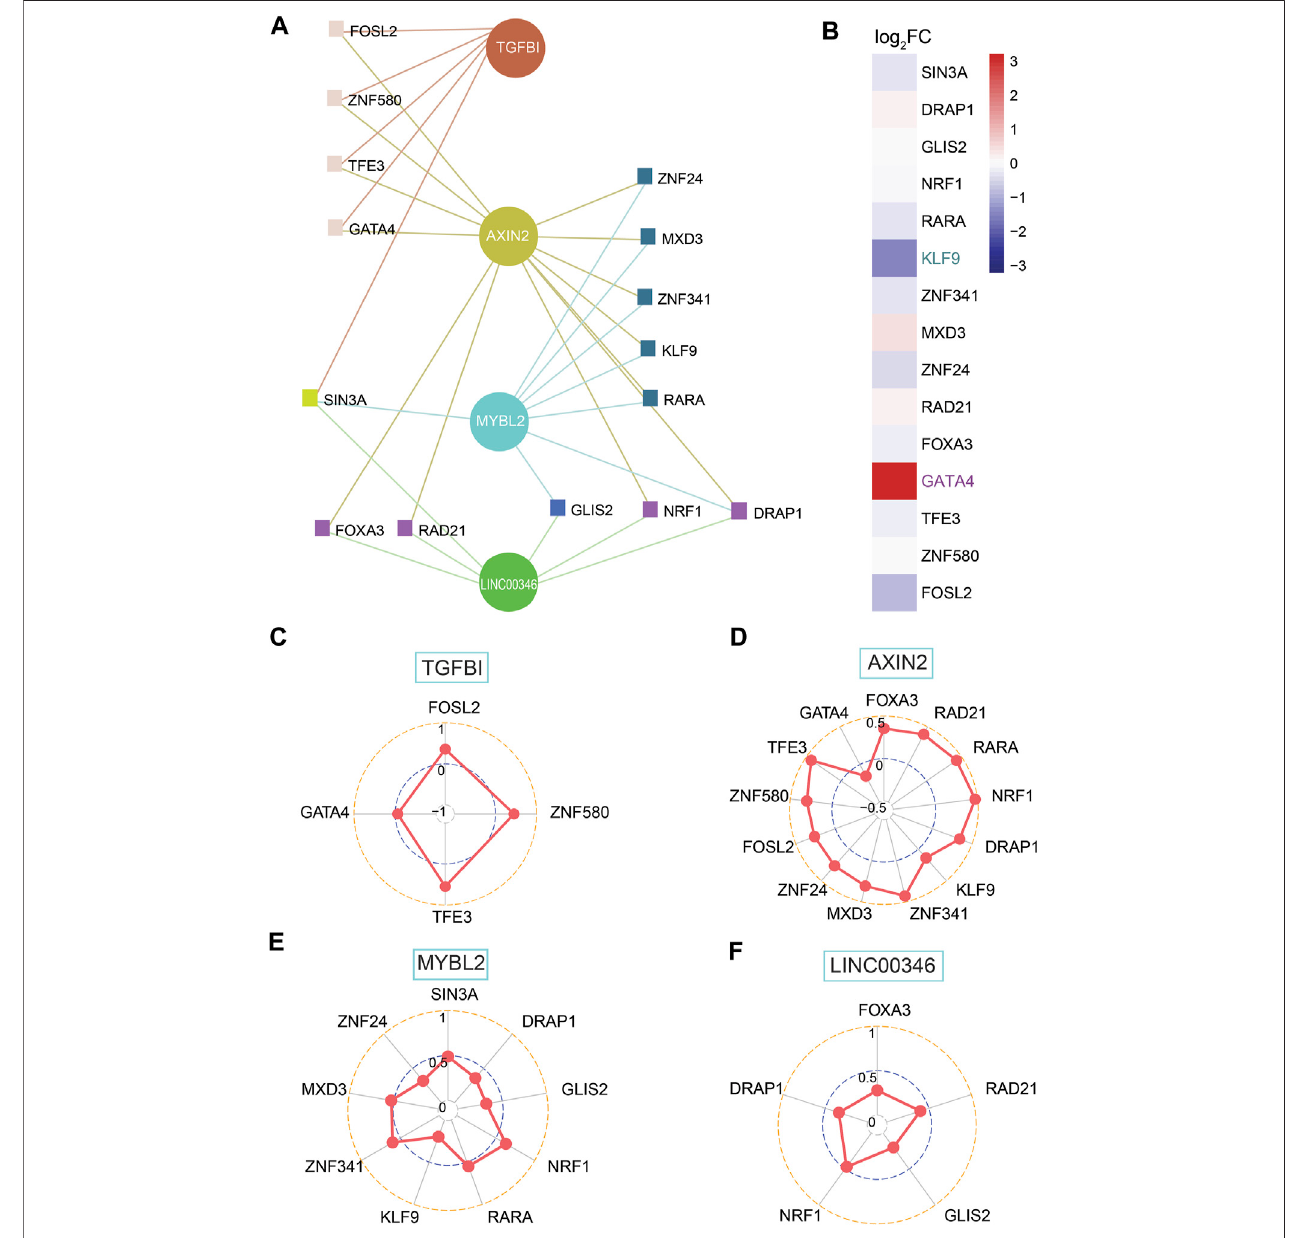
FIGURE 7 | Investigation of shortlisted genes and transcription factors (TFs) together with correlation among them. (A) Network of shortlisted genes and TFs. (B) Heatmap of log 2 FC for RNA expression of 15 TFs (high expression: GATA4; low expression: KLF9, both of them is |log 2 FC| > 1.5). (C – F) SCC between TFs and genes, including TGFBI, AXIN2, MYBL2, and LINC00346, based on network among